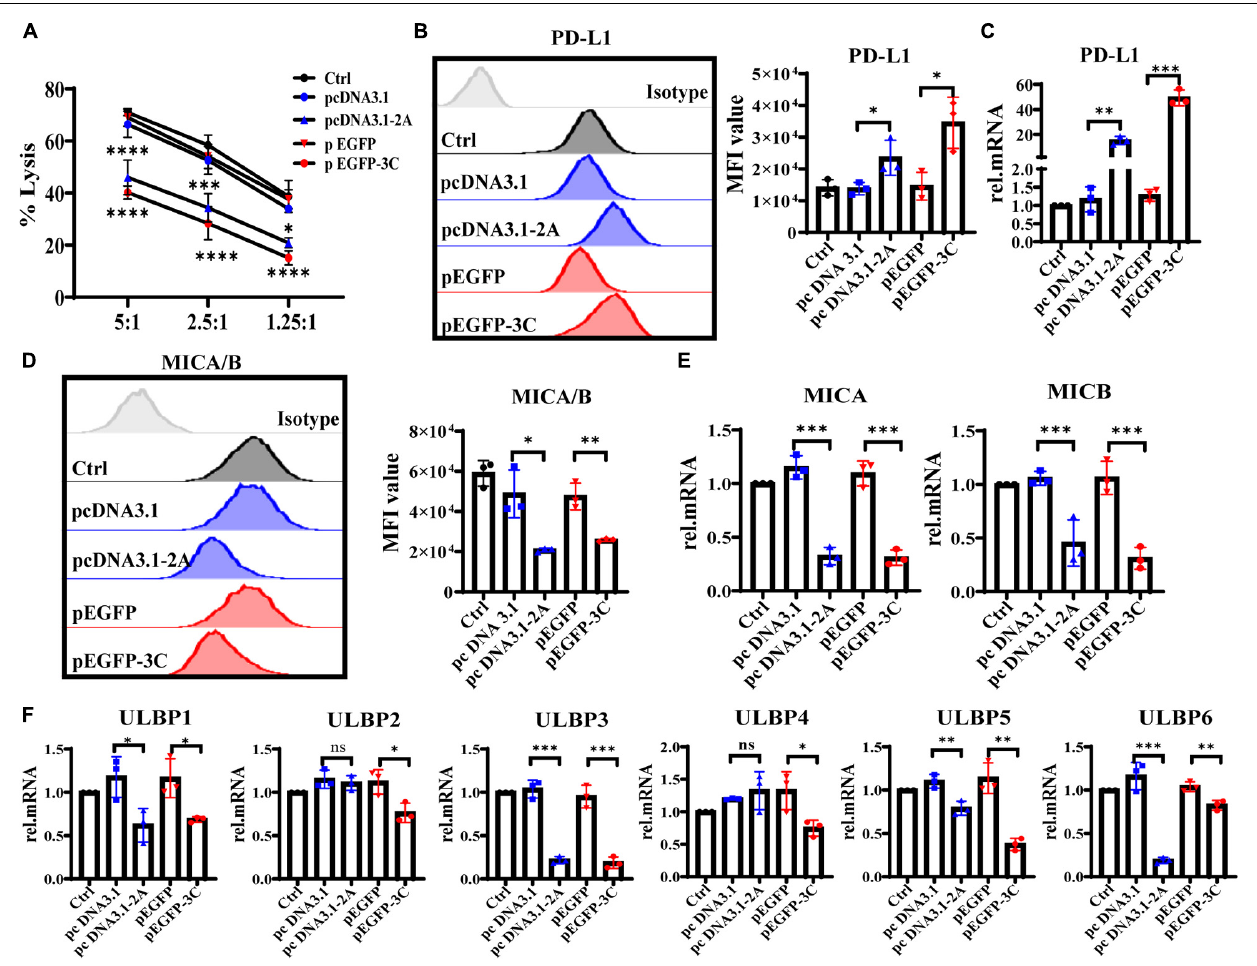
FIGURE 8 | The 2Apro and 3Cpro reduce the susceptibility of IECs to NK lysis by suppressing NKG2DL expression and improving PD-L1 expression on IECs. (A) Analyze the susceptibility of HT29 cells transfected with the pcDNA3.1-2A (pcDNA3.1) or p-EGFP-3C (p-EGFP) plasmids to NK-92 cell lysis on 6 h at the indicated E:T ratios by LDH. (B,D) HT29 cells were transfected with the four kinds of plasmids. After 24 h transfection, the cells were collected to detect the expression levels of PD-L1 and MICA/B by FACS. (C,E,F) The mRNA expression levels of PD-L1, MICA/B, and ULBP1 ∼ 6 were determined by qRT-PCR. Control was cells without any treatment. Dates were presented as mean ± SD ( n = 3 independent experiments, ∗ P < 0.05, ∗∗ P < 0.01, ∗∗∗ P < 0.001, ∗∗∗∗ P < 0.0001 and ns, not significant).